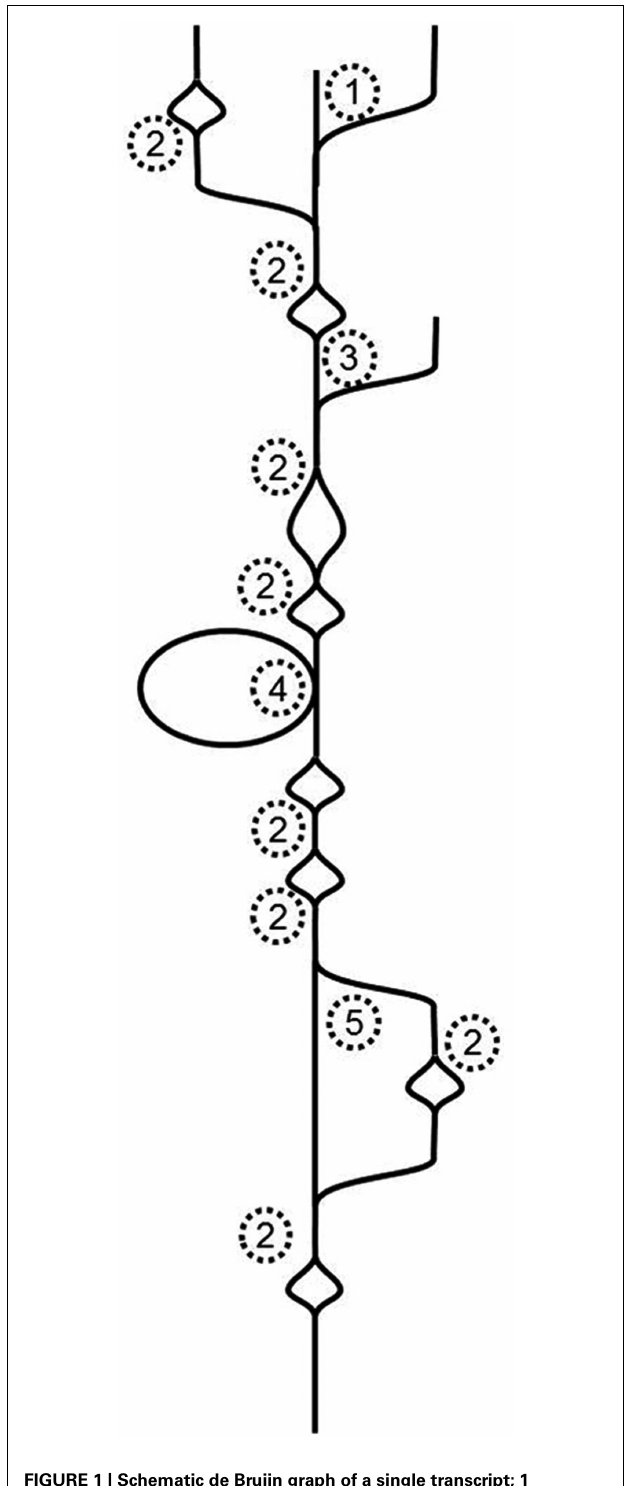
FIGURE 1 | Schematic de Bruijn graph of a single transcript; 1 alternative transcription start site or hybrid joining or DNA contamination; 2 SND caused by a sequencing error or a SNP or mutation after gene duplication; 3 alternative transcription start site or DNA contamination; 4 alternative exon use; 5 alternative exon use or mutations after recent gene